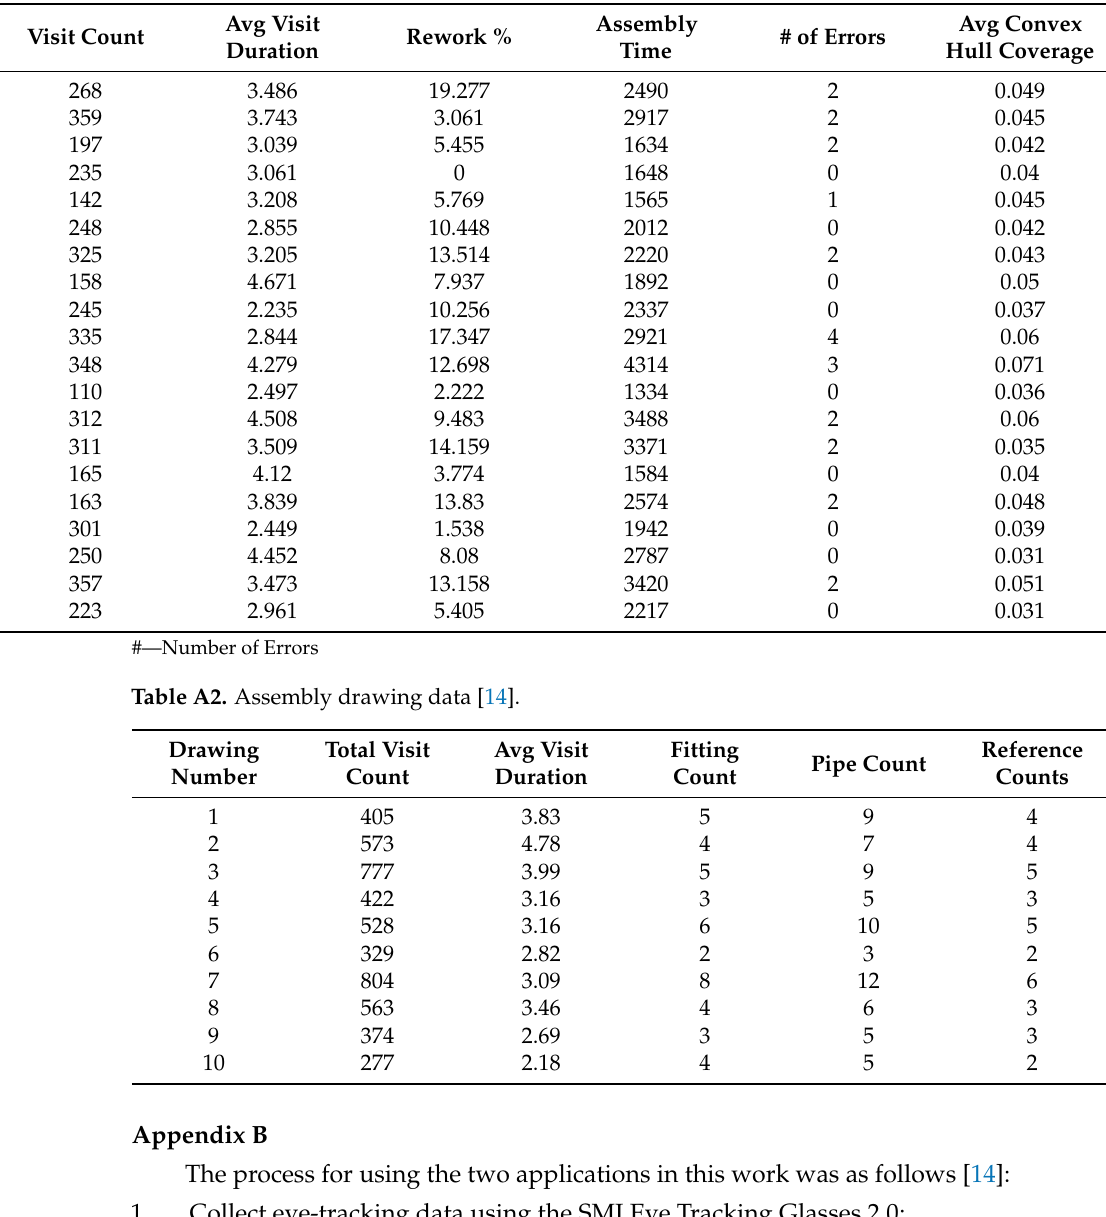
Table A1. Pipefitter data [14].